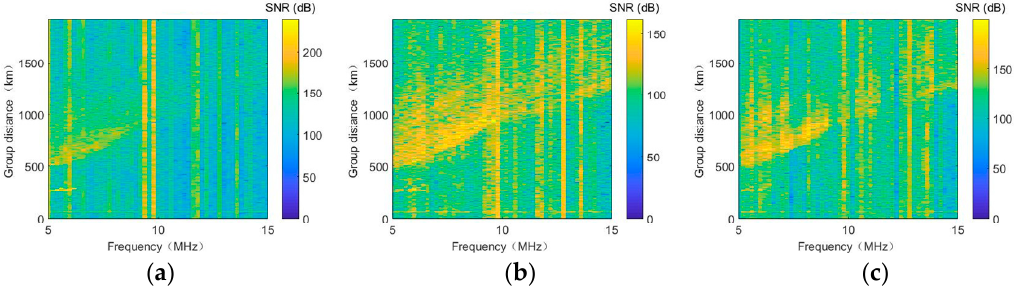
Figure 14. ( a ) The oblique backscatter ionogram of Channel 1; ( b ) The oblique backscatter ionogram of SMI; ( c ) the oblique backscatter ionogram of ESB.